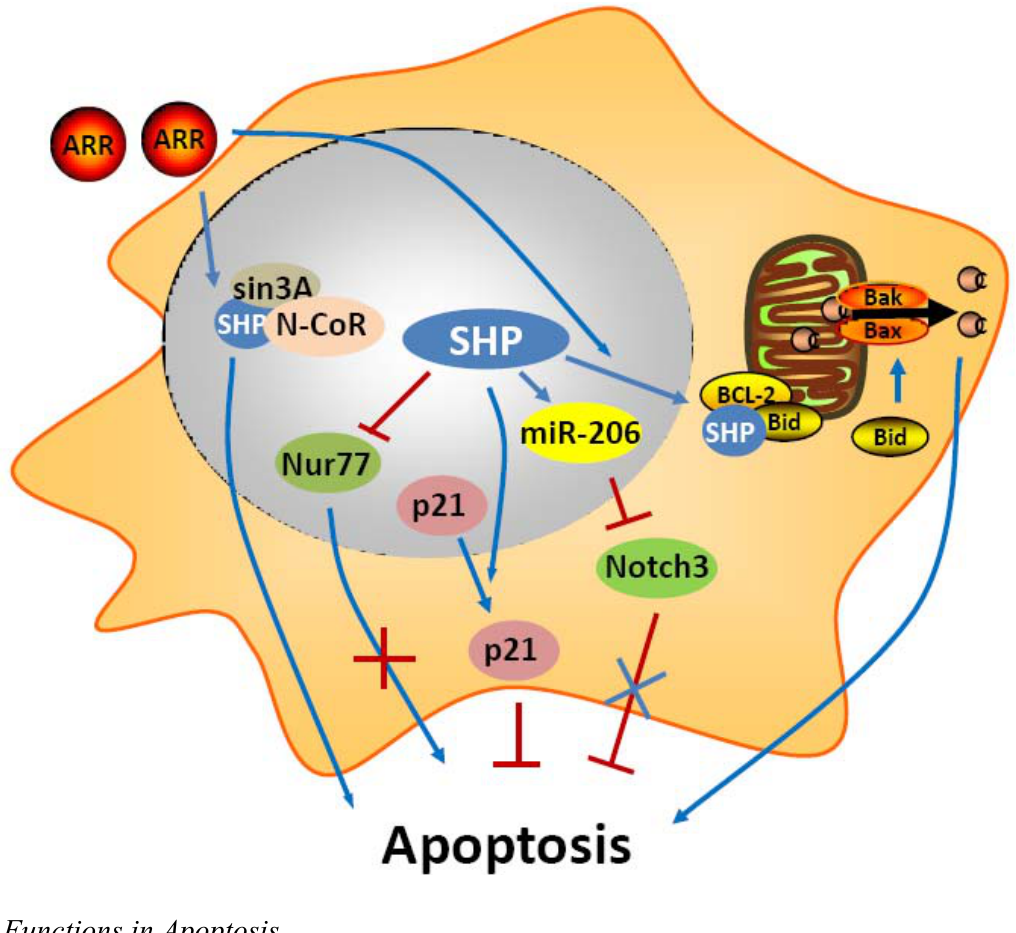
Figure 1. Role of SHP in apoptosis signaling. SHP is proposed to have both inhibitory and stimulatory effects on apoptosis (depending on cell types). SHP represses apoptosis through inhibiting the transcription of Nur77 and inducing the cytoplasmic sequestration of p21WAF1. SHP activates apoptosis by translocating to mitochondria, binding to the anti-apoptotic protein Bcl-2, and disrupting Bcl-2/Bid interaction to cause cytochrome c release. SHP also activates apoptosis through regulating miR-206 expression to block the anti-apoptotic activity of Notch3. The adamantyl-substituted retinoid-related (ARR) compounds AHPN and 3-Cl-AHPC bind directly to SHP, which promotes the formation of a corepressor complex containing Sin3A, nuclear receptor co-repressor ( N -CoR) to activate apoptosis. ARRs also increase SHP protein stability by preventing its degradation and enhance SHP mitochondrial targeting. Activation pathways are shown as blue arrows, and inhibitory pathways are shown as red